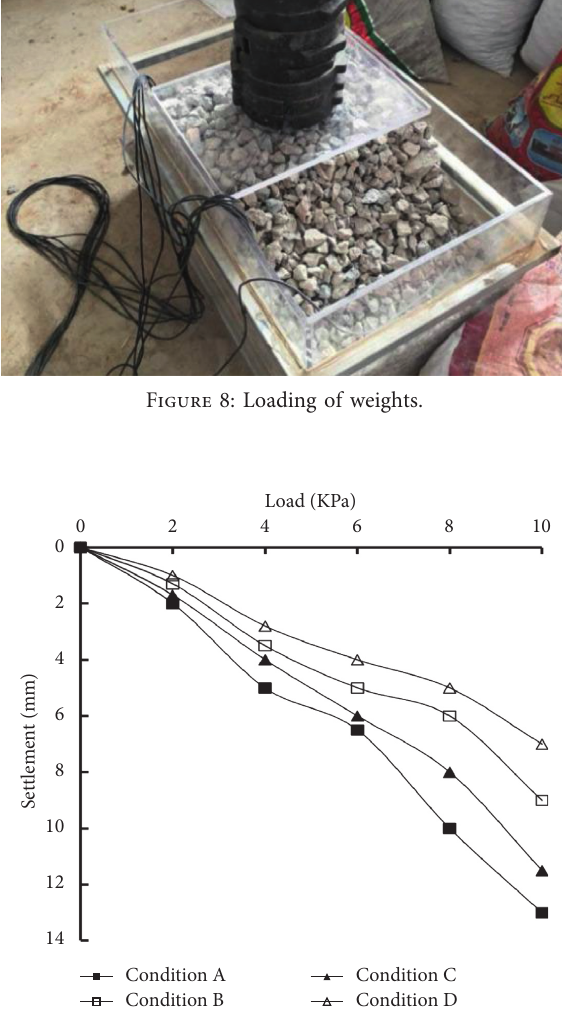
Figure 9: P–S curve of trapezoidal filling structure axis under four testing